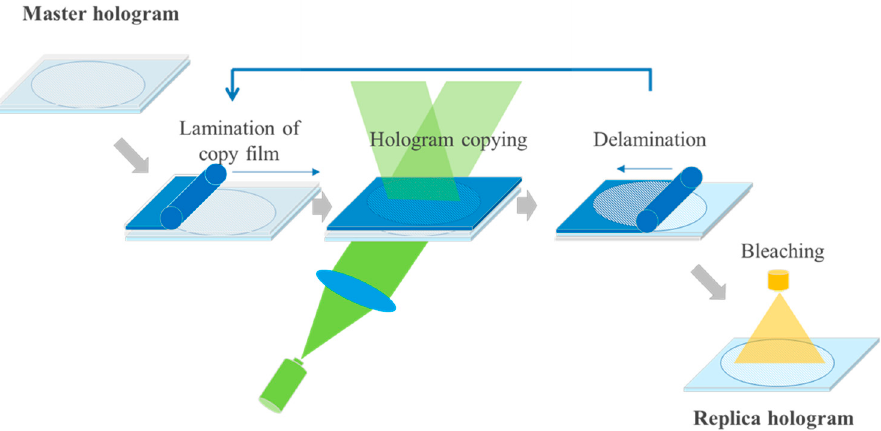
Figure 23. Contact copy scheme of a transmission vHOE. From left to right: The copy film is laminated onto the master vHOE; a laser beam illuminates the master vHOE “On Bragg”, whereby the master vHOE acts as a beam splitter that generates the object beam. This object beam interferes with the residual 0th order beam behind the master vHOE, thereby creating the interference pattern that is recorded into the copy film; downstream within a few seconds the dark reaction is finished; the copy film is delaminated from the master vHOE and protected by re-masking with a cover film; bleaching and fixing is done as last step further downstream [55].